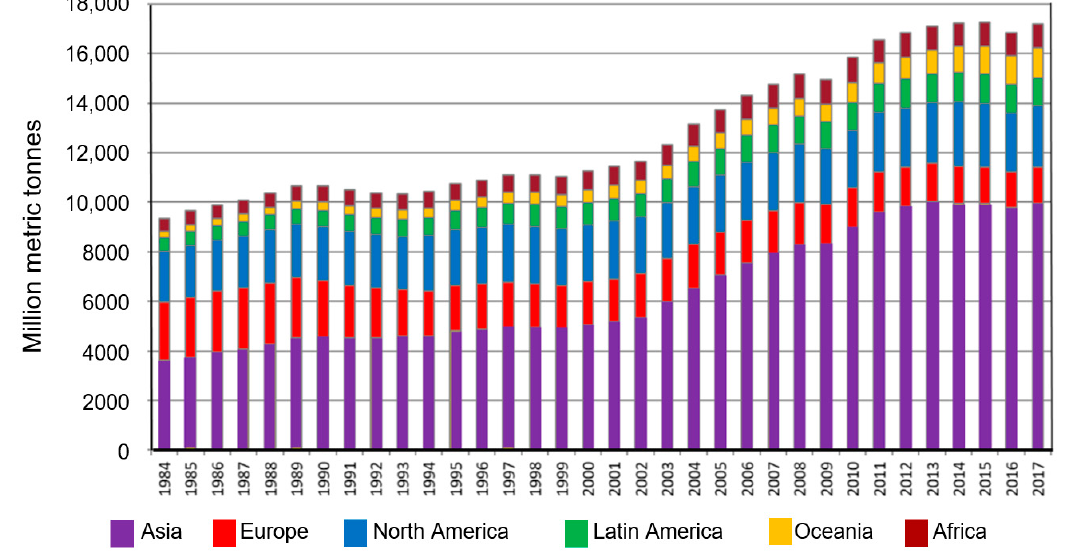
Figure 1. World mining production 1984–2017 by groups of minerals (without construction minerals) (own elaboration based on data from [30]).